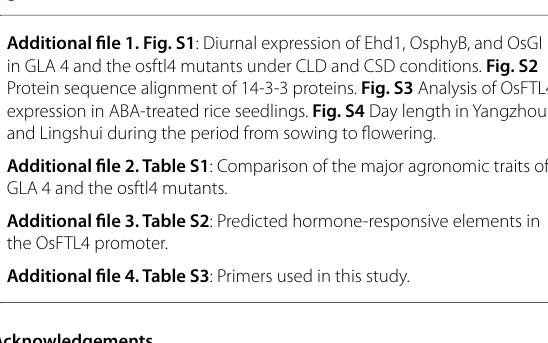
Additional file 2. Table S1 : Comparison of the major agronomic traits of GLA 4 and the osftl4 mutants. Additional file 3. Table S2 : Predicted hormone-responsive elements in the OsFTL4 promoter. Additional file 4. Table S3 : Primers used in this